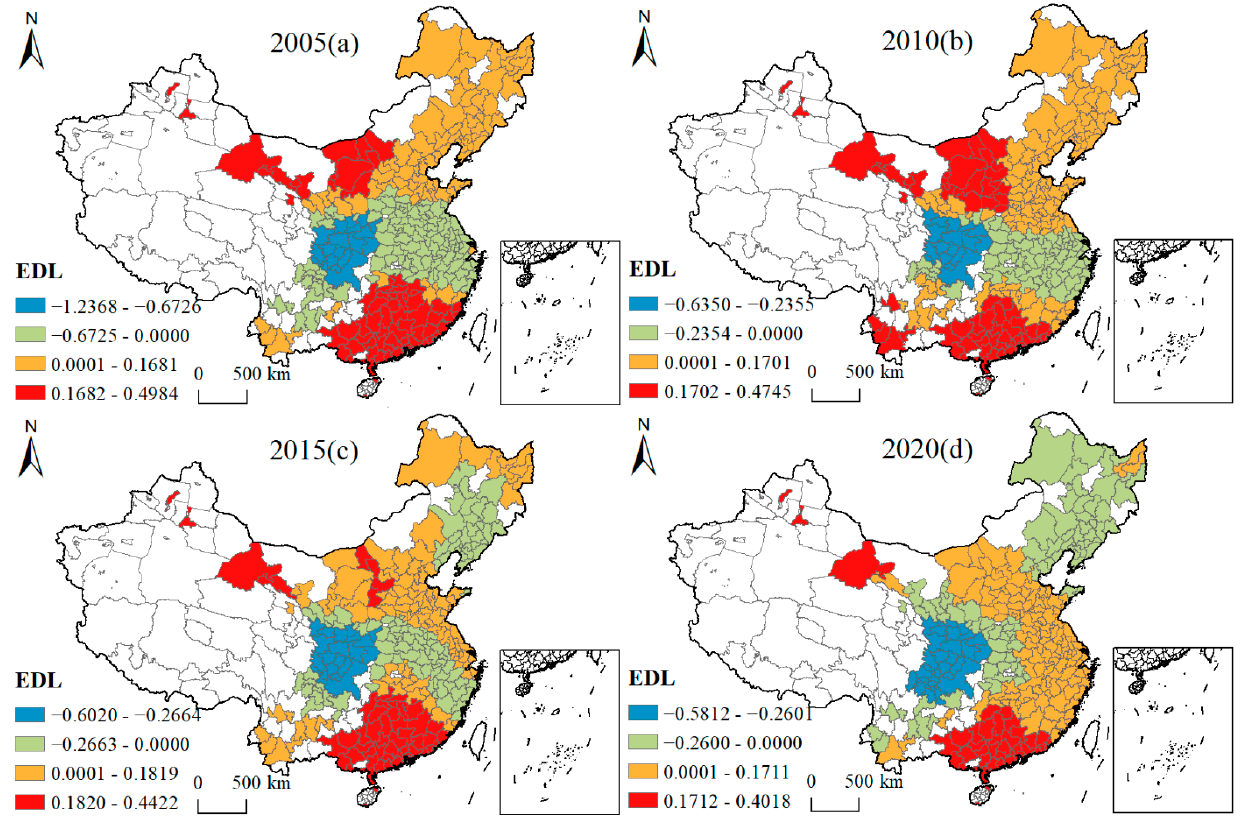
Figure 5. Four-year regression coefficients of